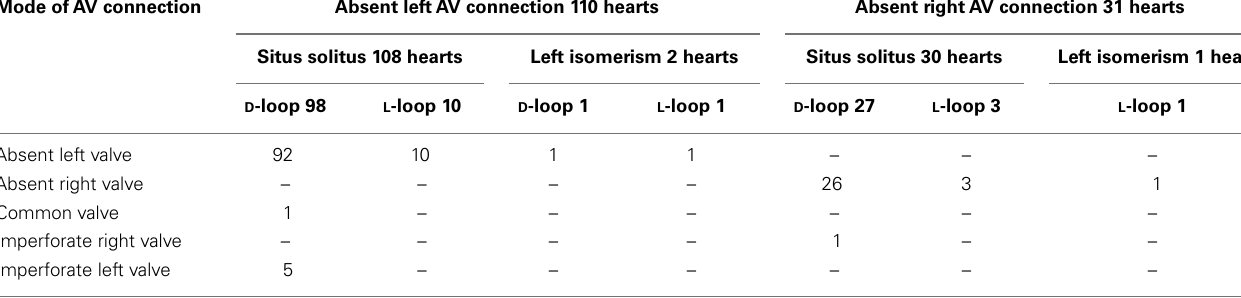
Table 5 |AbsentAV connections: mode ofAV connection